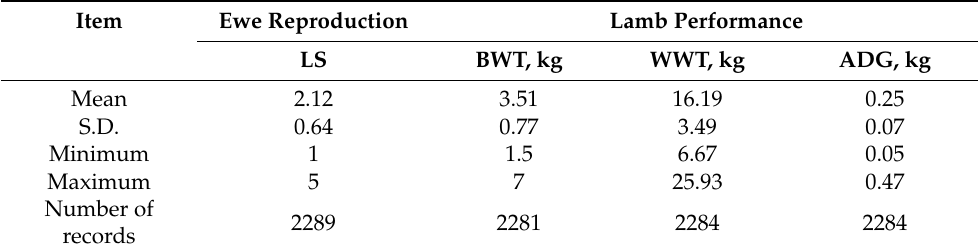
Table 1. Descriptive statistics for ewe reproduction and lamb